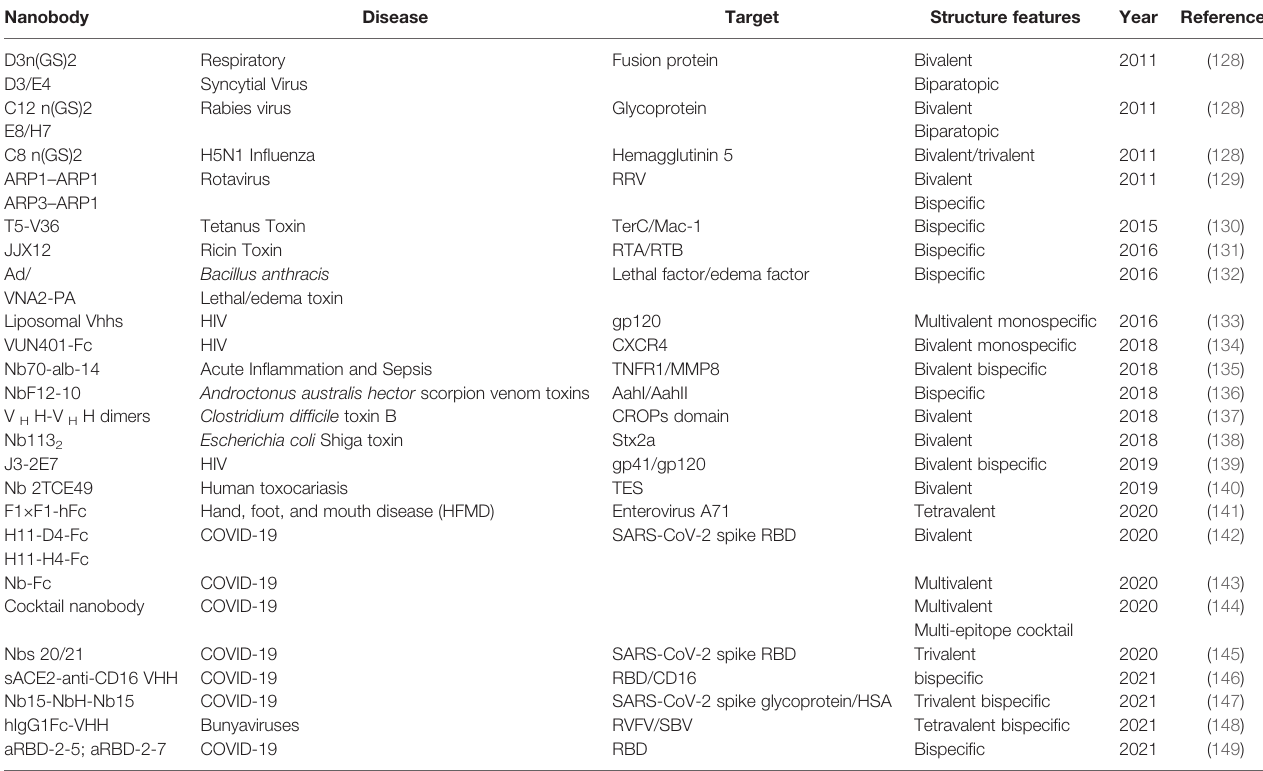
TABLE 4 | Multivalent/bispeci fi c nanobodies for infectious diseases.